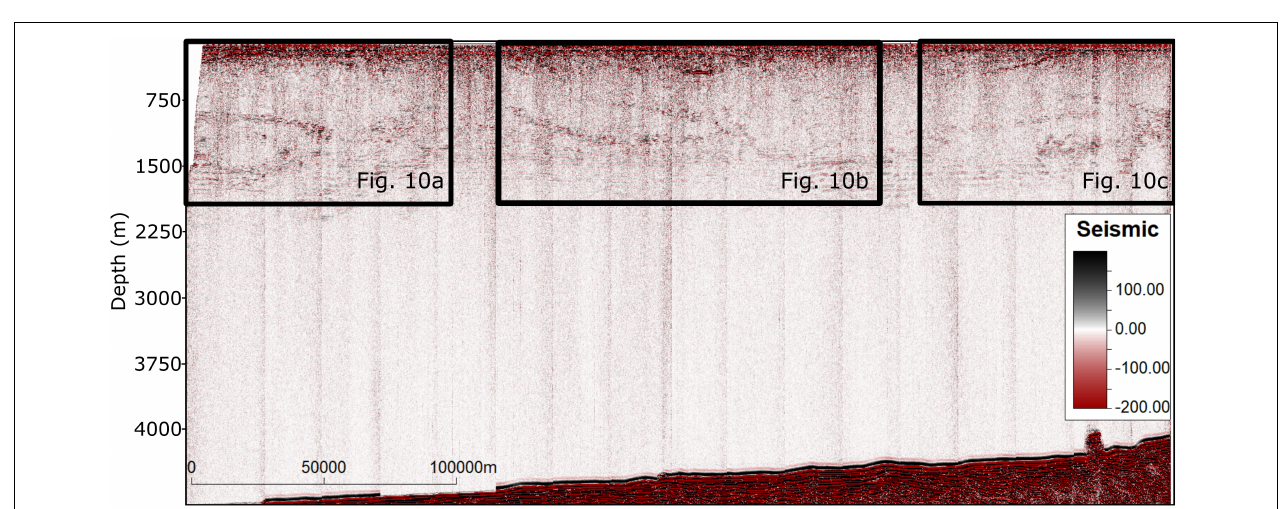
FIGURE 9 | Migrated seismic profile. Black boxes represent the locations of the zoom-ins shown in Figure 10